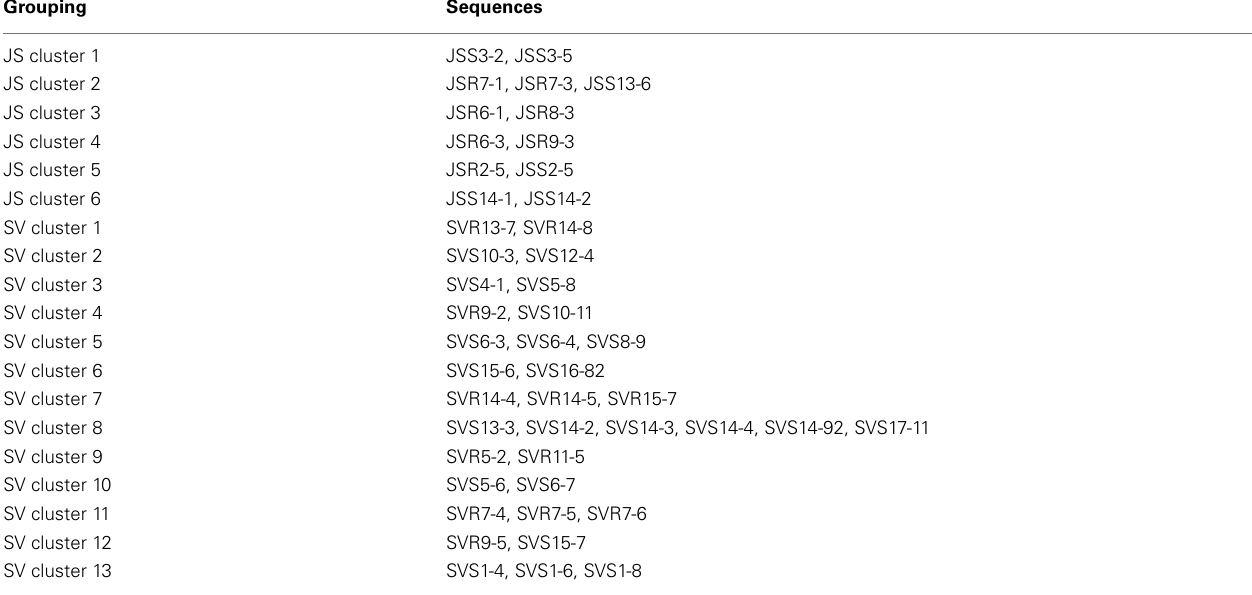
TableA2 | Sequences included in the plant host clusters designated in Figure 5.